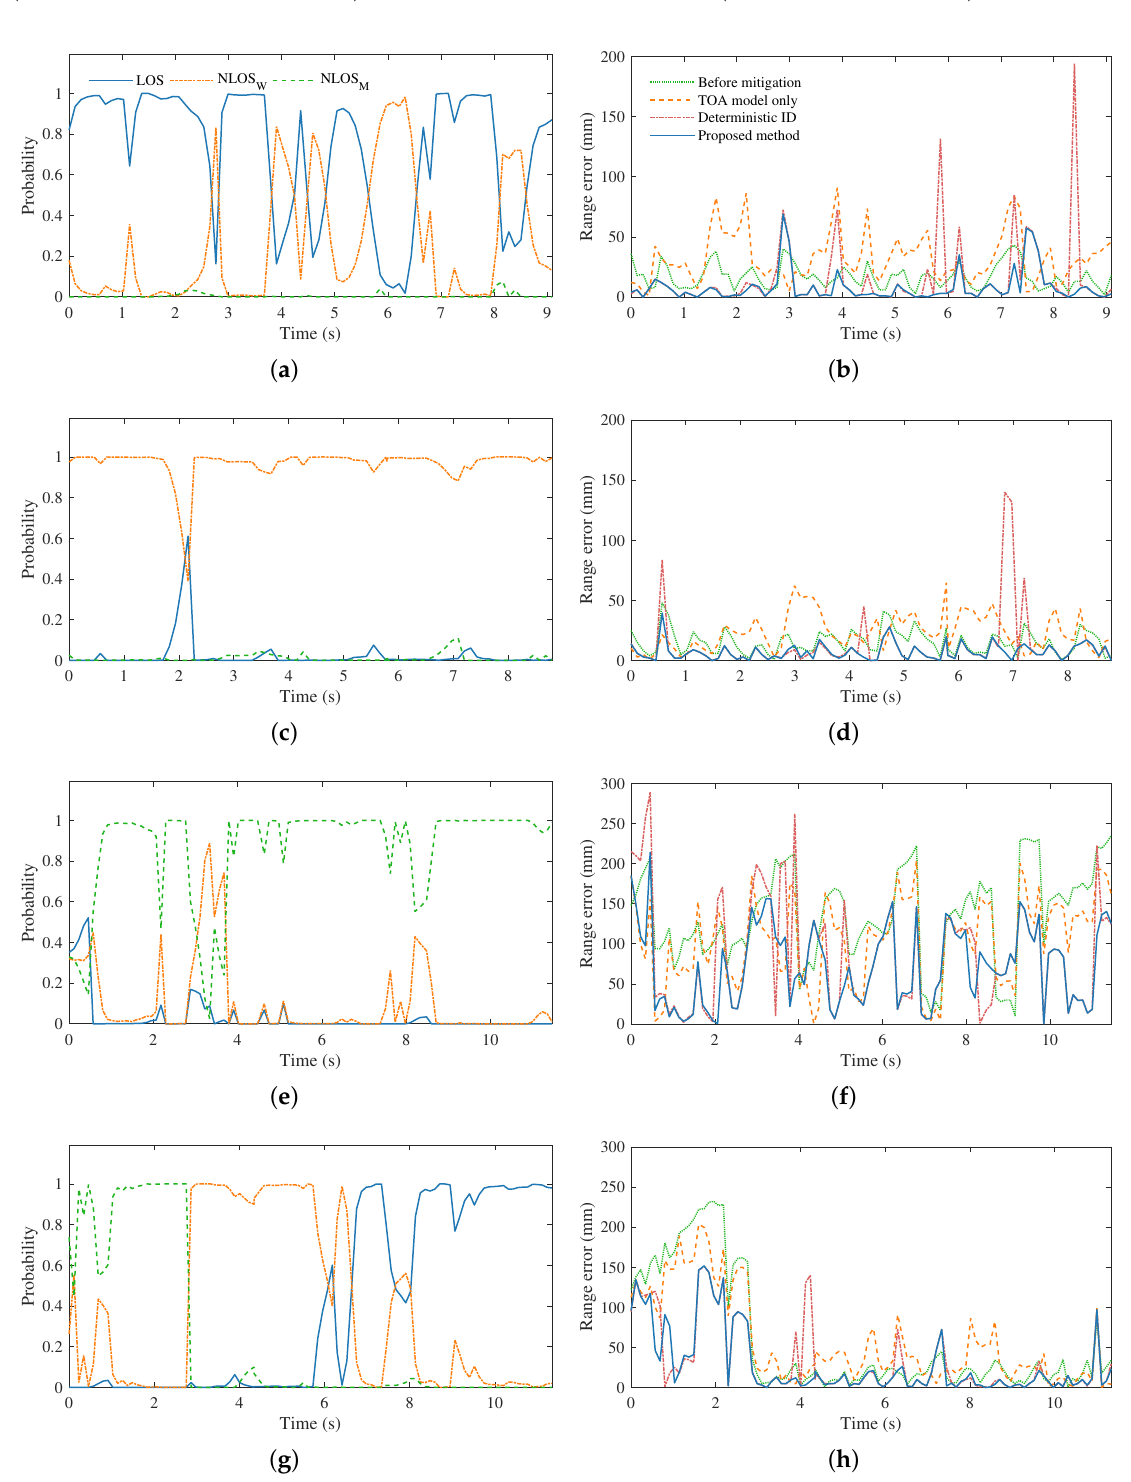
Figure 5. Experiment results of the inter-robot ranging. The obstacle type identification results of LOS , NLOS W , NLOS M and the mixture subcases are shown in ( a , c , e , g ), respectively. The ranging error results of the corresponding subcases are presented, respectively, in ( b , d , f , h